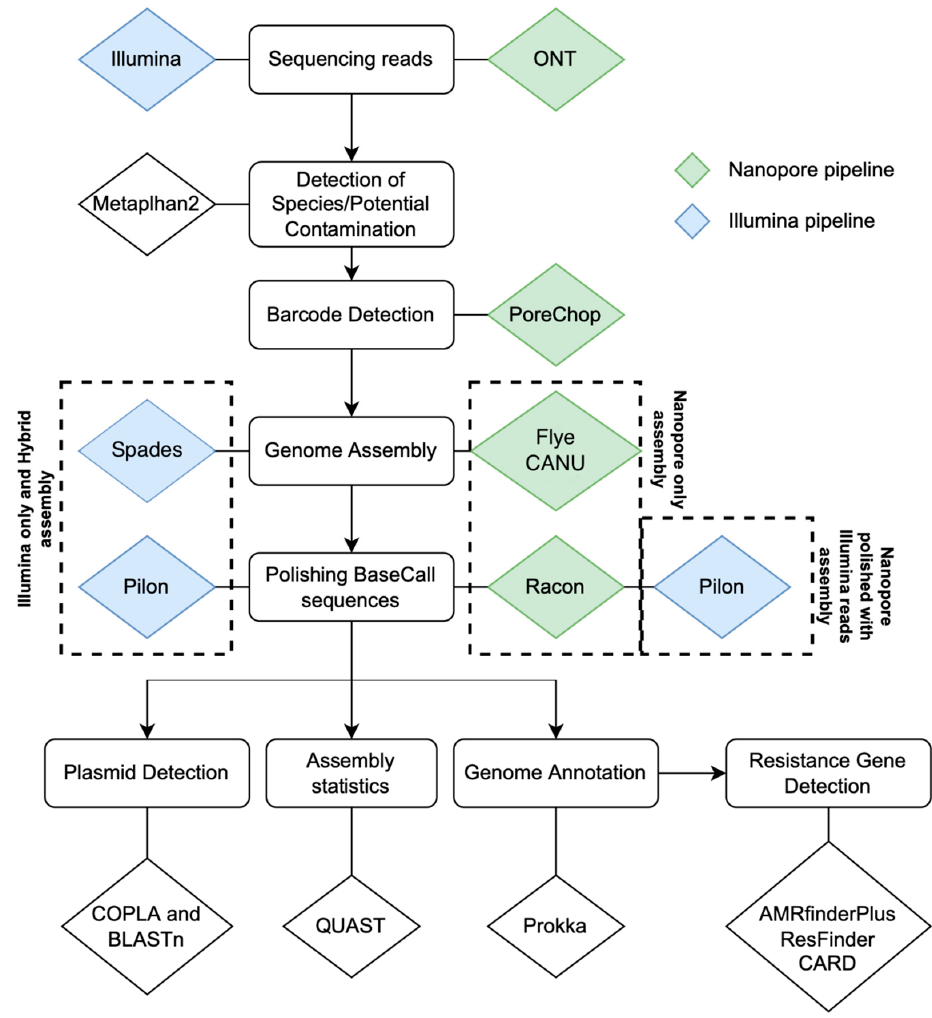
Figure 2. The bioinformatics pipeline used for the total genomic and plasmid DNA sequencing analysis. The total genomic DNA and plasmid-only DNA were sequenced using two sequencing chemistries (Illumina and Oxford Nanopore Technologies (ONT)). Reads were assembled using four different approaches: Nanopore-only: MinION reads were assembled with Flye, without error correction by Illumina reads; Nanopore-polished: MinION reads were assembled with Flye and polished with Illumina reads; and Illumina-only: Illumina reads were assembled with SPADES, without error correction with Nanopore reads. Illumina-hybrid: assembly of Illumina reads and Nanopore reads with hybridSPADES and polished with Illumina reads. Blue triangles: Illumina. Green triangles: ONT. AMR genes were identified using three different databases: